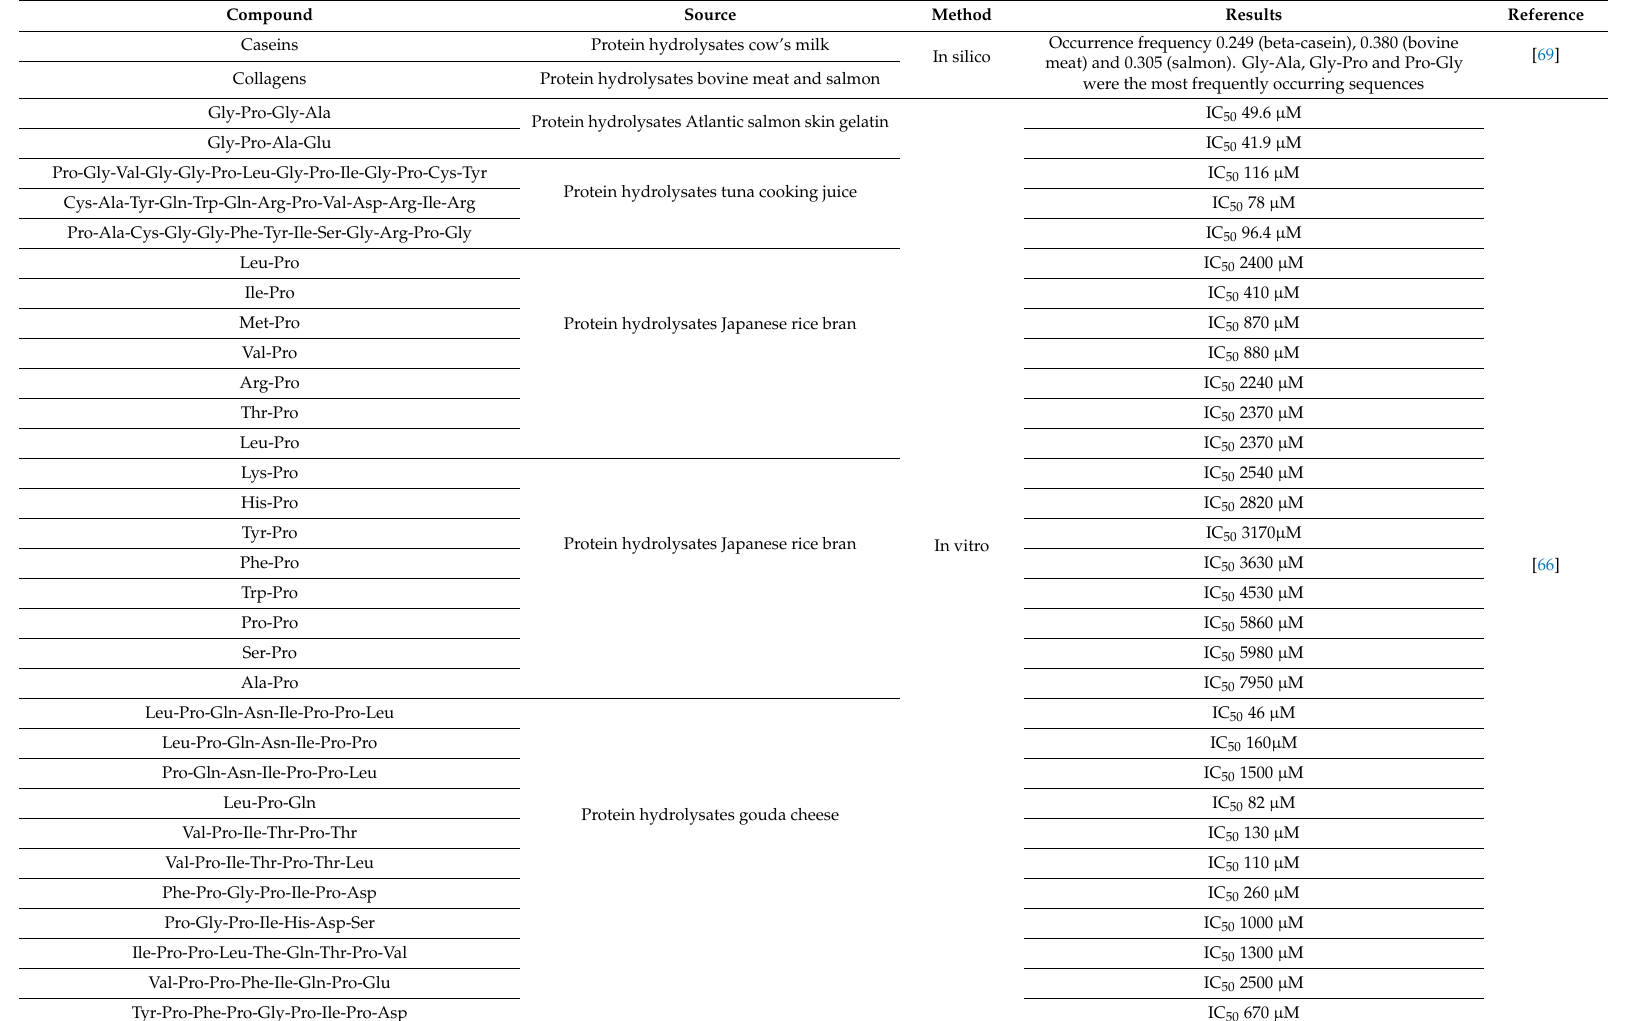
Table 3. Natural DPP4